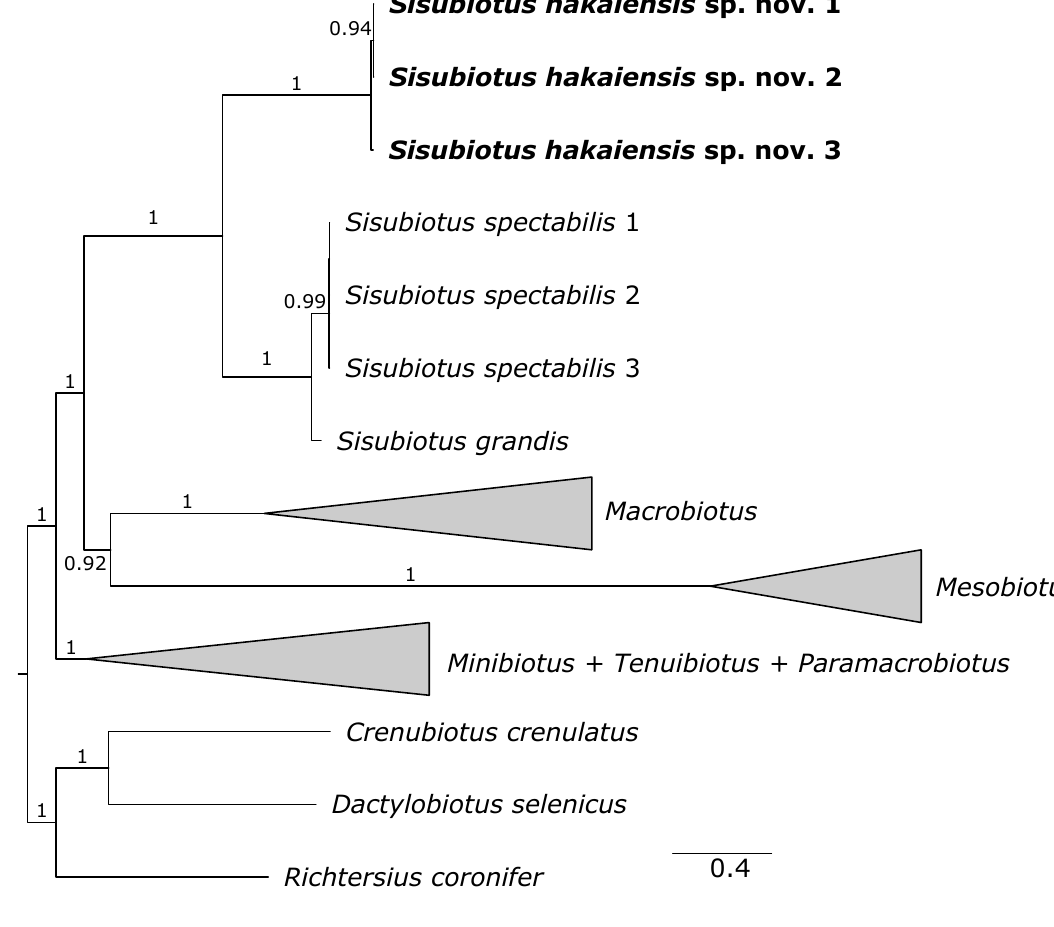
Fig. 1. Bayesian phylogenetic placement of the new species of Sisubiotus Stec, Vecchi, Calhim & Michalczyk, 2021. Values above/below branches are Bayesian posterior probability values. Scale bar indicates